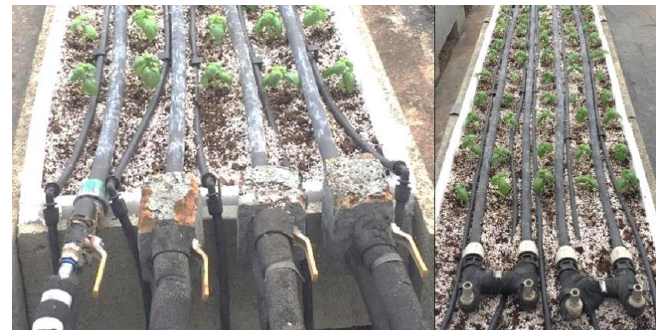
Figure 4. Detail of the coaxial pipes and basil plant layout.